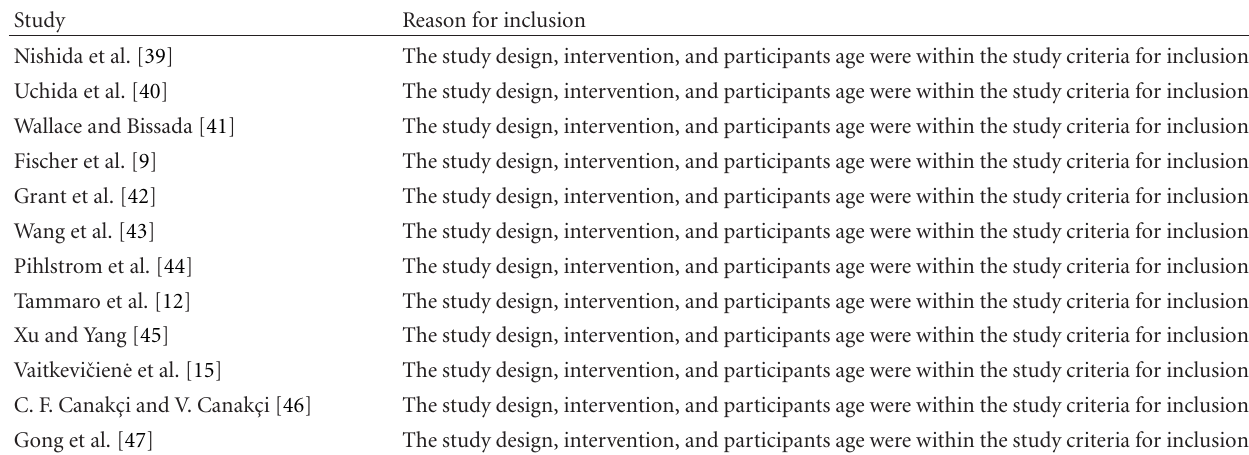
Table 2: Characteristics of included studies (reasons for